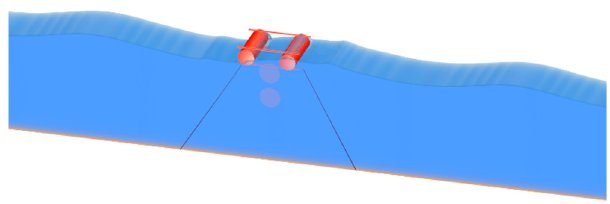
Figure 4. Flow field scalar diagram.